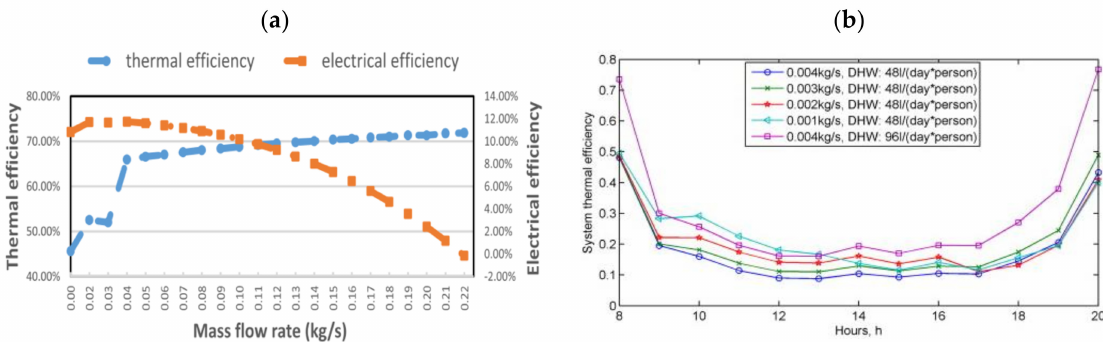
Figure 19. ( a ) Thermal and electrical efficiency of the system for different mass flow rates (reprinted from [110], with permission from publisher); ( b ) thermal efficiency profile for various mass-flow rate and hot water profile (reprinted from [111], with permission from publisher).